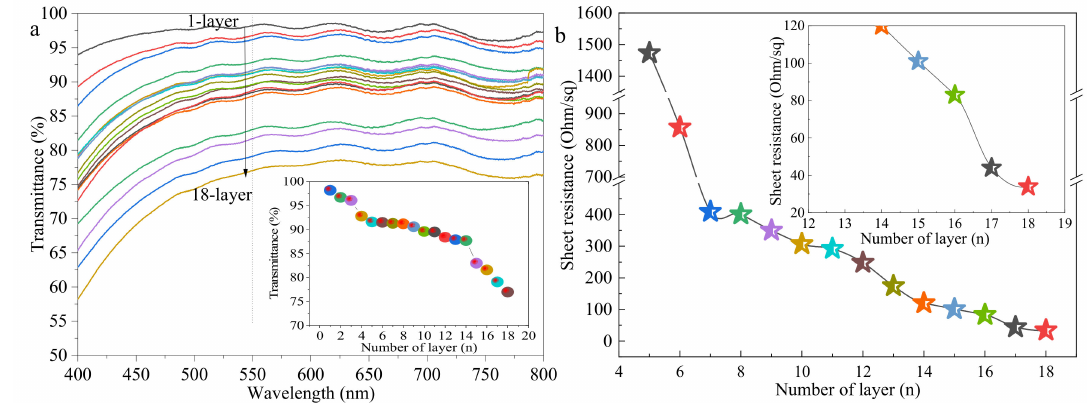
Figure 5. Optical transmittance ( a ) and ( b ) sheet resistances of samples with different printed layers. The inserts are optical transmittance at 550 nm in ( a ) and local magnification in ( b